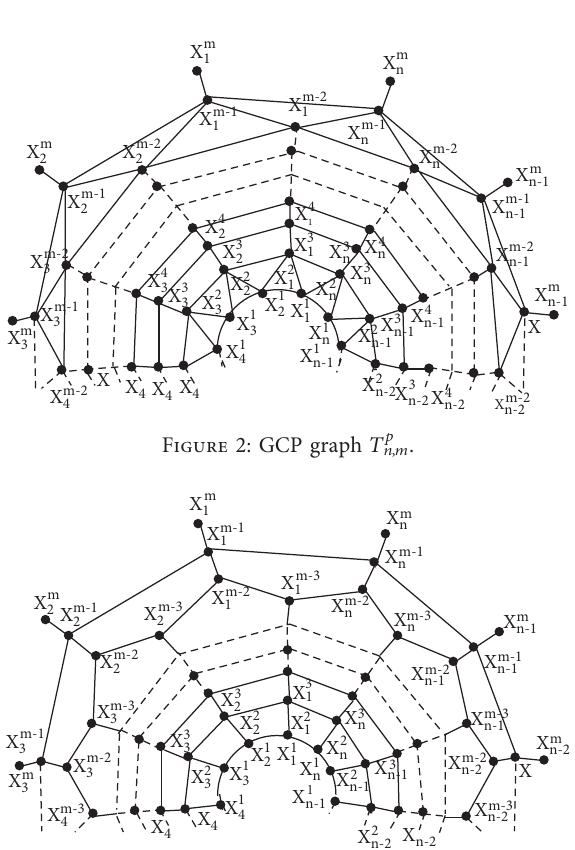
Figure 3: The generalized convex polytope graph U p